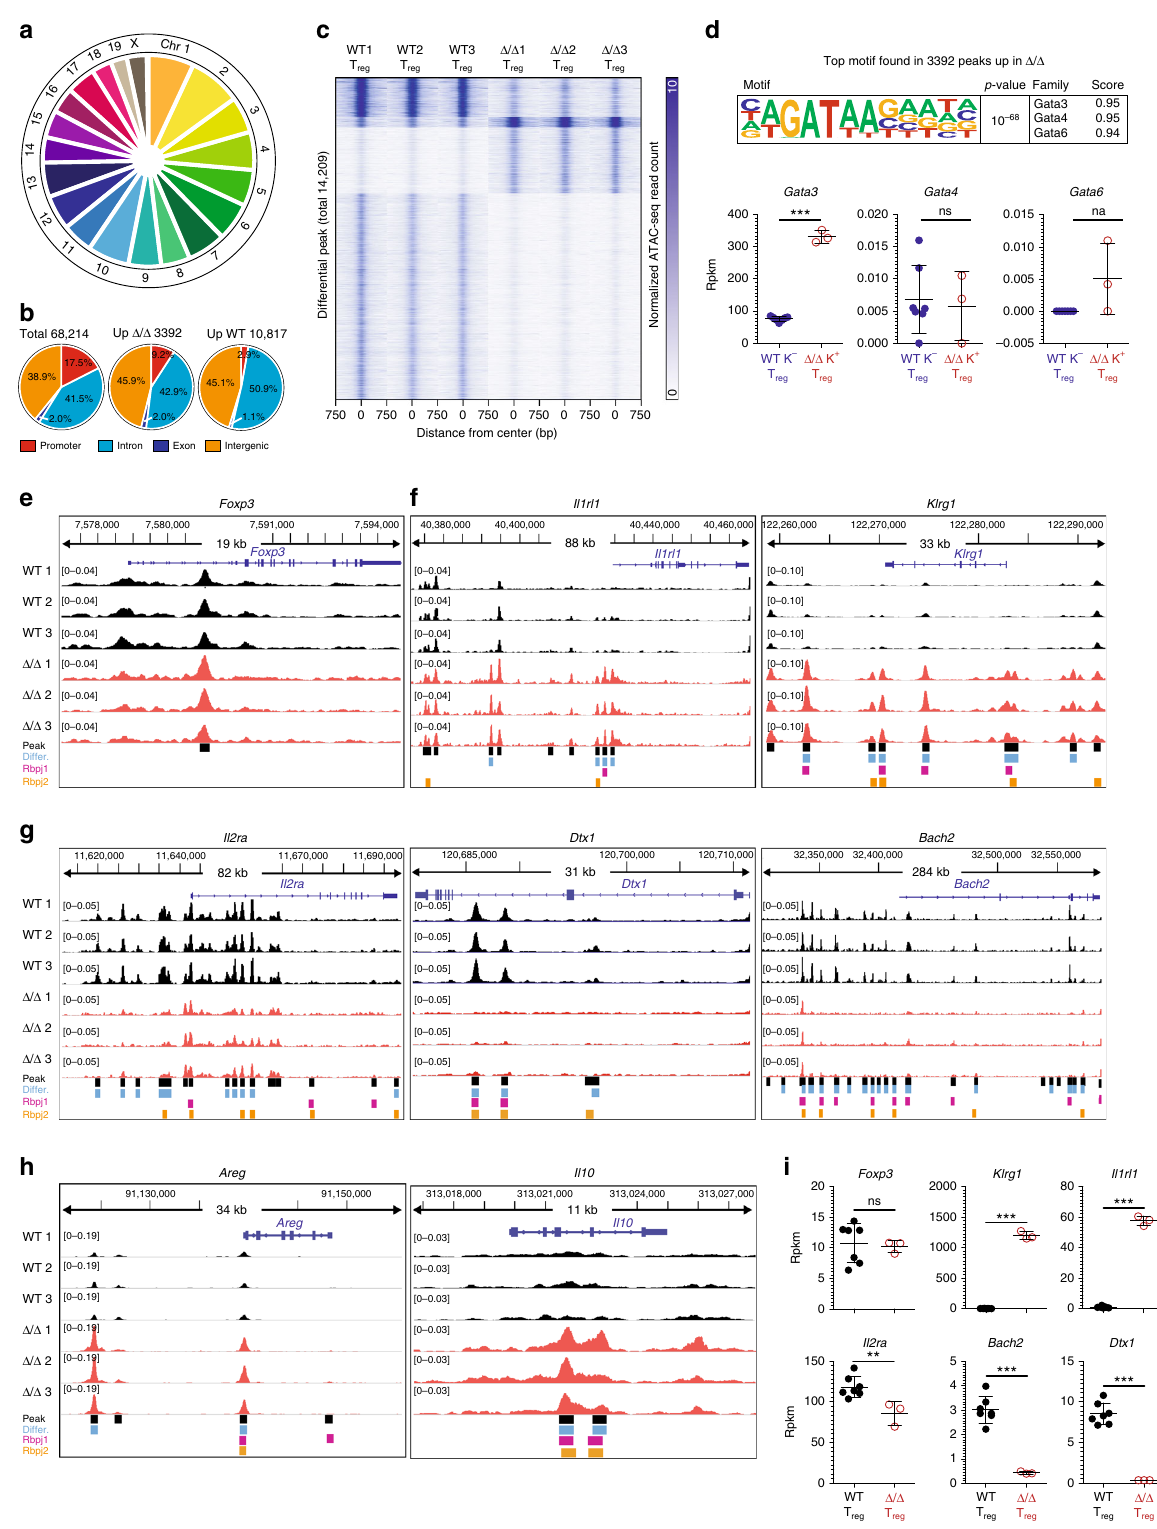
( Foxp3 Cre Rbpj wt/ Δ ) and 40 wildtype animals ( Foxp3 Cre Rbpj wt/wt ), 0 animals showed signs of disease. Rbpj genotyping . Animal tails were digested in digest buffer (50 mM KCl, 20mM Tris – HCl pH 8.8, 0.00045% Tween20 and Igepal CA-630) with proteinase K overnight at 56°C. Following inactivation for 10min at 96 °C, a PCR reaction